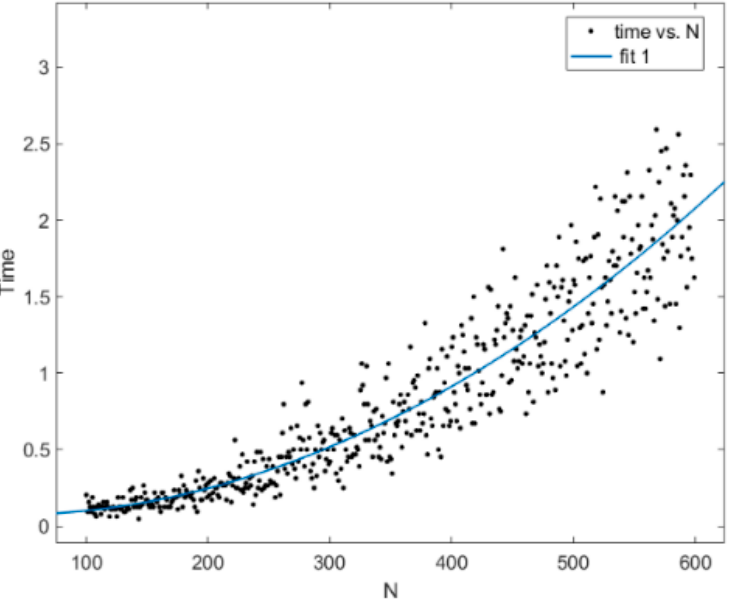
Figure 16. The computational time complexity curve line.